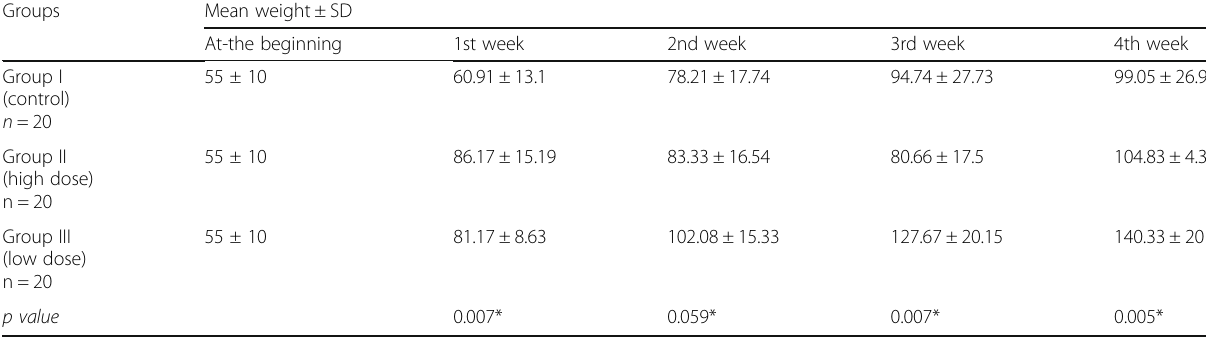
Table 1 Weight comparison between rats in the three groups using one way Anova test